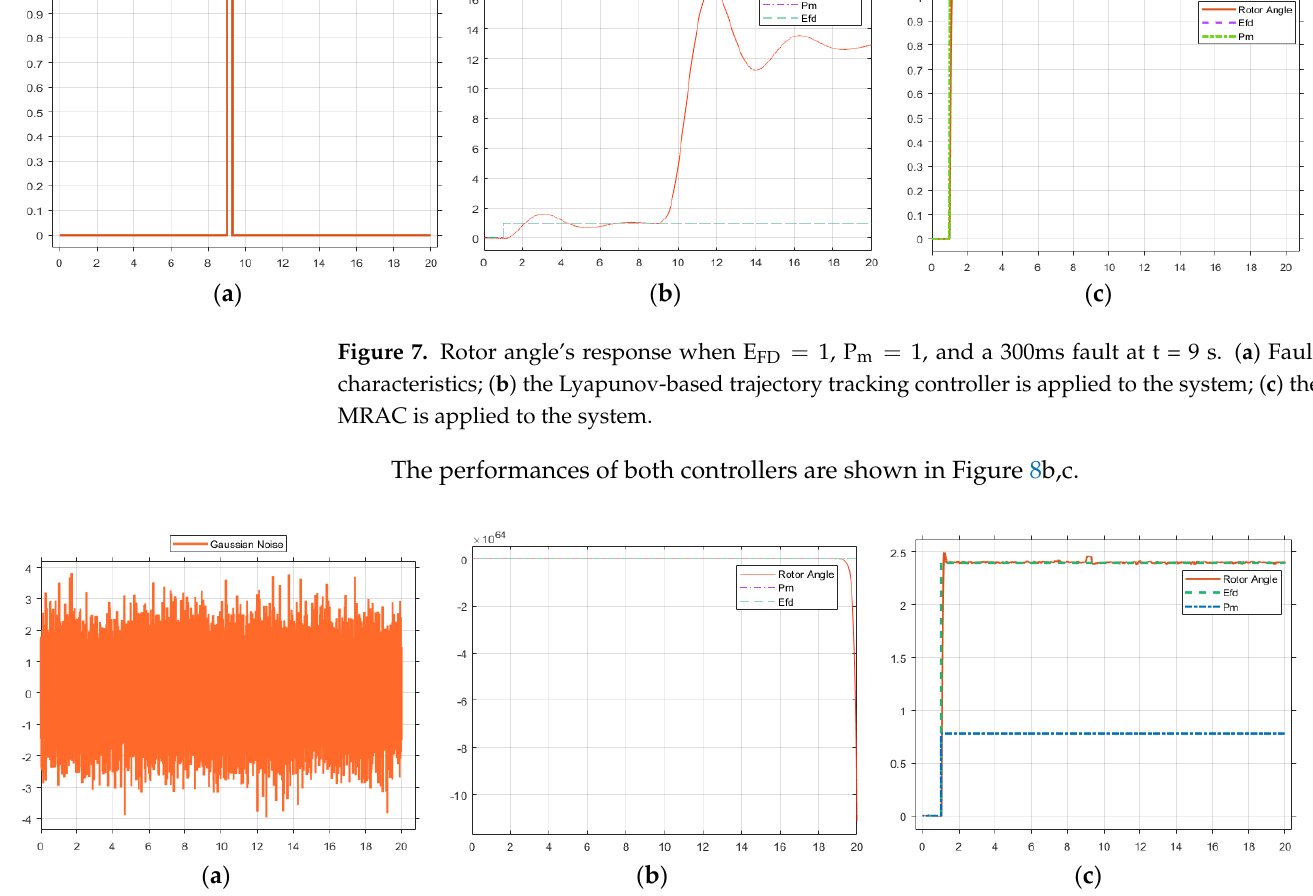
Figure 8. Rotor angle’s response when E (cid:2890)(cid:2888) = 2.395 , P (cid:2923) = 1 ,Gaussian noise, and a 300 ms fault at t = 9 s. ( a ) Gaussian noise characteristics; ( b ) the Lyapunov-based trajectory tracking controller is applied to the system; ( c ) the MRAC is applied to the system.